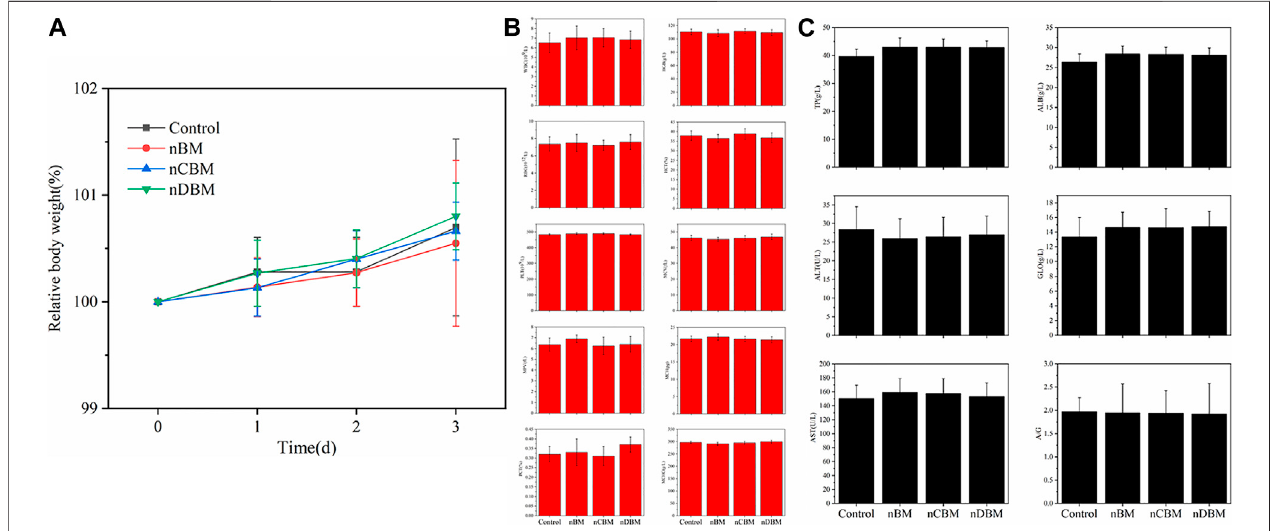
FIGURE 6 | Body weight (A) , blood routine (B) , and biochemical indicators (C) of mice during the experiment.